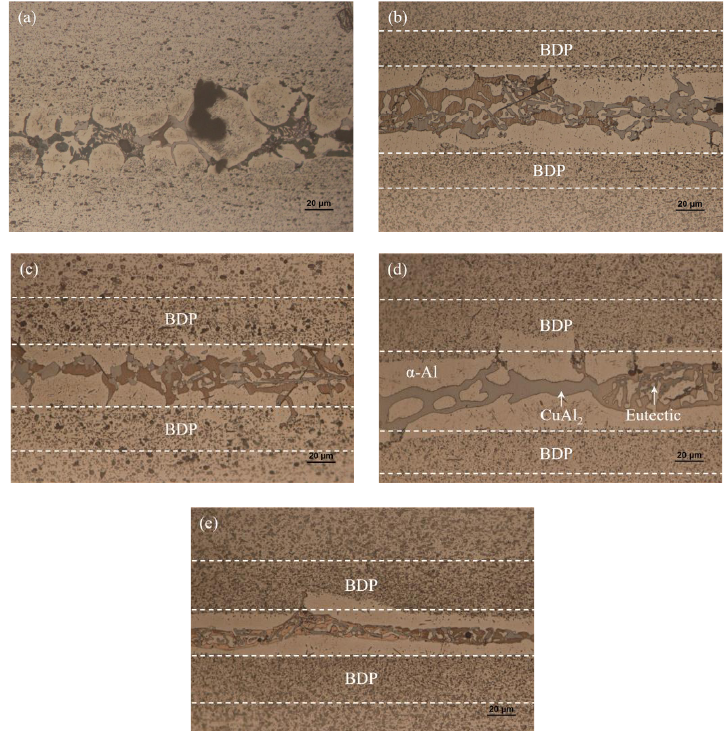
Figure 7. Microstructure of the joint brazed with different temperature and dwell time: ( a ) 565 °C and 15 min; ( b ) 570 °C and 15 min; ( c ) 575 °C and 15 min; ( d ) 575 °C and 20 min; ( e ) 575 °C and 25 min. and 15 min; ( b ) 570 ◦ C and 15 min; ( c ) 575 ◦ C and 15 min; ( d ) 575 ◦ C and 20 min; ( e ) 575 ◦ C and 25 min.